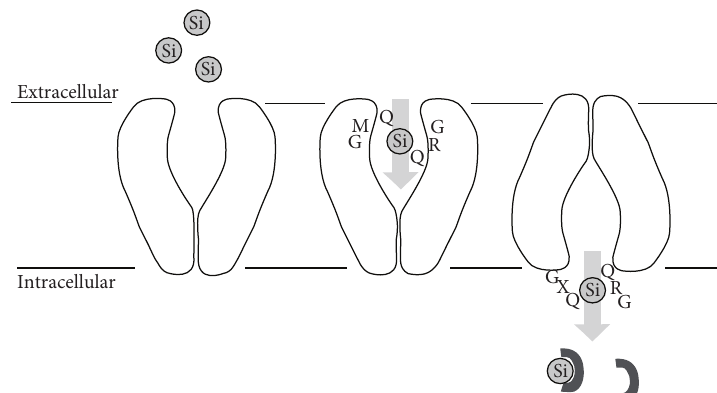
F 5: Proposed model of silicon transport through the 10-transmembrane diatom transporter. e outward-facing conformation binds extracelllar silicate through hydrogen bonding to 2 conserved Gln in the transmembrane helices 7 and 8. A conformational change to an inward-facing conformation allows silicate to bind to other conserved Gln in the loop between helices 2 and 3, releasing silicate into the cell to be bound by as yet unknown components. Reproduced with permission from